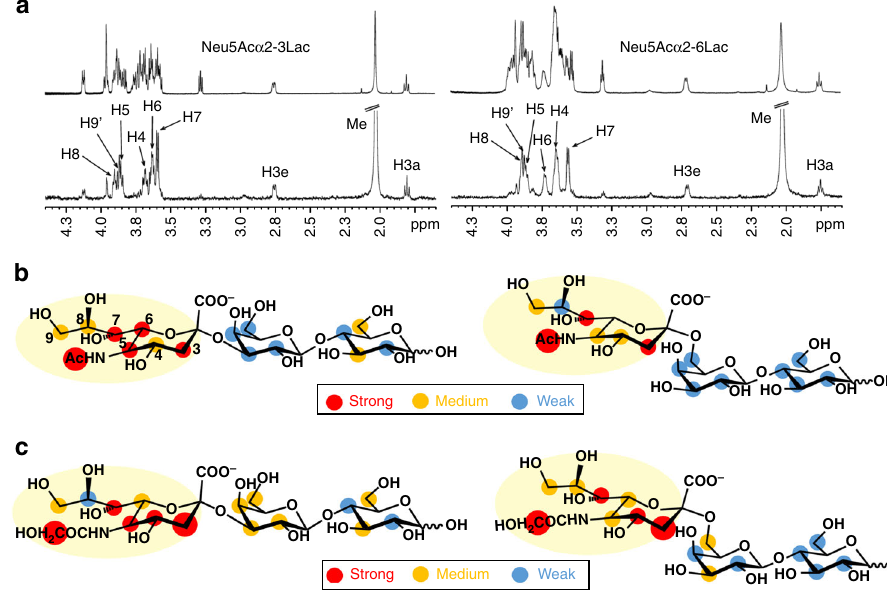
Fig. 5 STD NMR analysis of Rg CBM40 binding to sialoglycans. a Reference (top) and difference (bottom) spectra of 3 ′ SL and 6 ′ SL. The strongest signals from the Neu5Ac ’ s protons are labelled in the difference spectra. b Binding epitope mapping from STD NMR of 3 ′ SL and 6 ′ SL. Legend indicates relative STD intensities normalised at H7: blue, 0 – 24%; yellow, 25 – 50%; red 51 – 100%; larger red dots indicate values over 100%. Sialic acid is the main recognition element. c Binding epitopes mapping from STD NMR of Neu5Gc α 2-3Lac and Neu5Gc α 2-6Lac. Legend as above. Sialic acid is the main recognition element. The strongest STD intensities from CH2 and the H3s, suggest a reorientation of the Neu5Gc ring in the binding pocket, in comparison to 3 ′ SL and 6 ′ SL